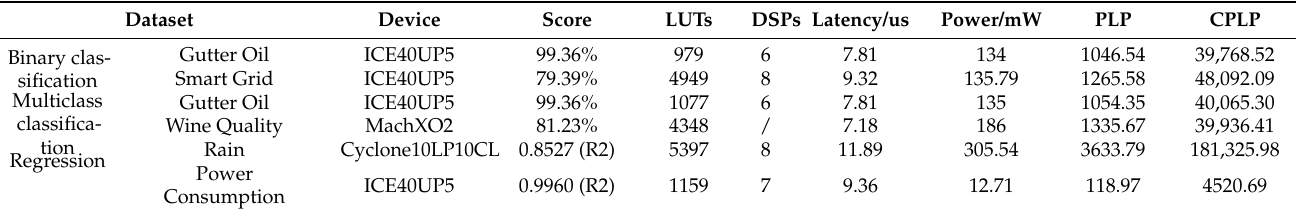
Table 12. The k-NN deployment results on the best CPLP-performing